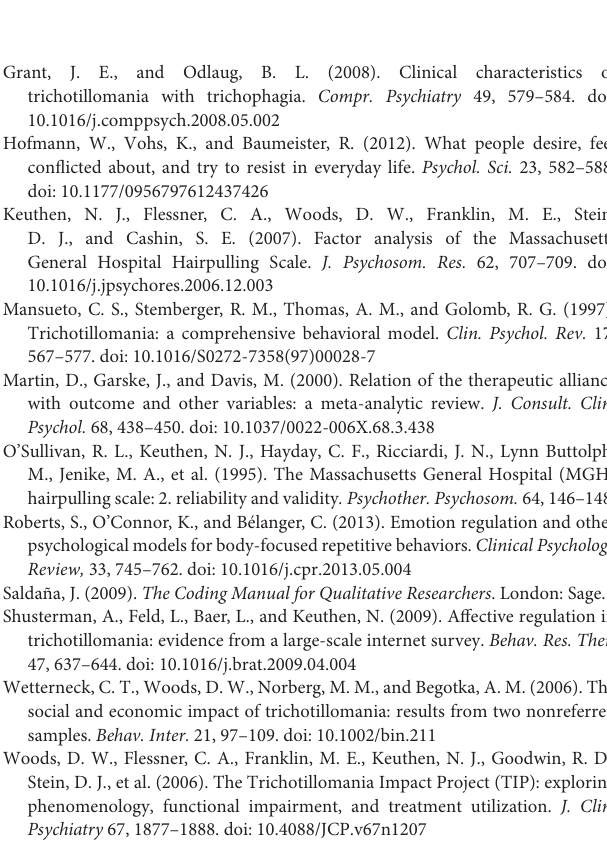
that one urge was “slightly” ( > ) more severe than the other, or that one urge was “much” more severe ( >> ) than the other. Supplementary Figure 3 | Affective changes associated with urge satisfaction. UF– group: Plots of the changes in reported affect before, during, and after hair pulling (HP) or eating an unhealthy food (UF). Supplementary Table 1 | UF + group: Mean ratings (1–5) of affective states before, during, and after hair pulling (HP) or unhealthy food (UF) urge satisfaction. Supplementary Table 2 | UF − group: Mean ratings (1–5) of affective states before, during, and after hair pulling (HP) or unhealthy food (UF) urge satisfaction. Supplementary Table 3 | UF − group: Results of a repeated measures ANOVA for nine different emotions examining the main effects of urge type (hair pulling or unhealthy food urges), time, and the urge type ∗ time interaction. The Greenhouse-Geisser correction was applied where appropriate. (df, degrees of